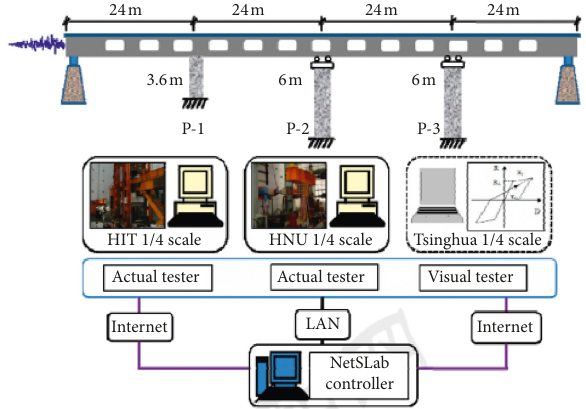
Figure 9: Remote collaboration testing in China.